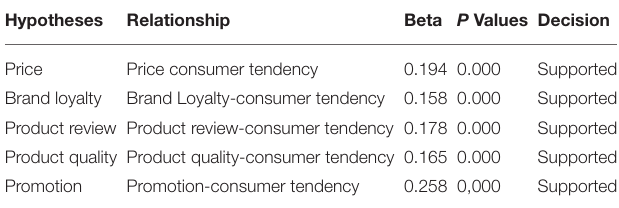
TABLE 3 | Structural equation model